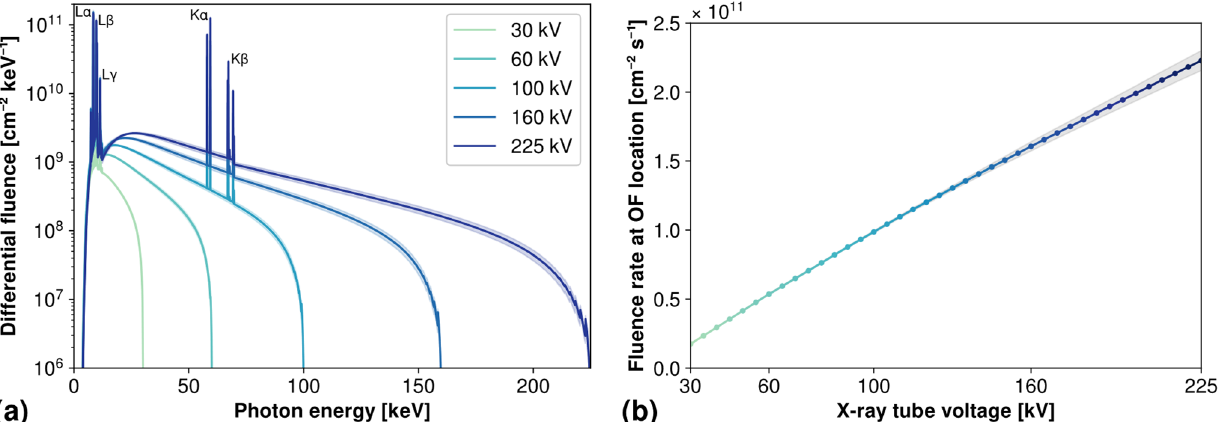
Table 2. Main characteristic X-ray emission lines for element tungsten (W) [45].